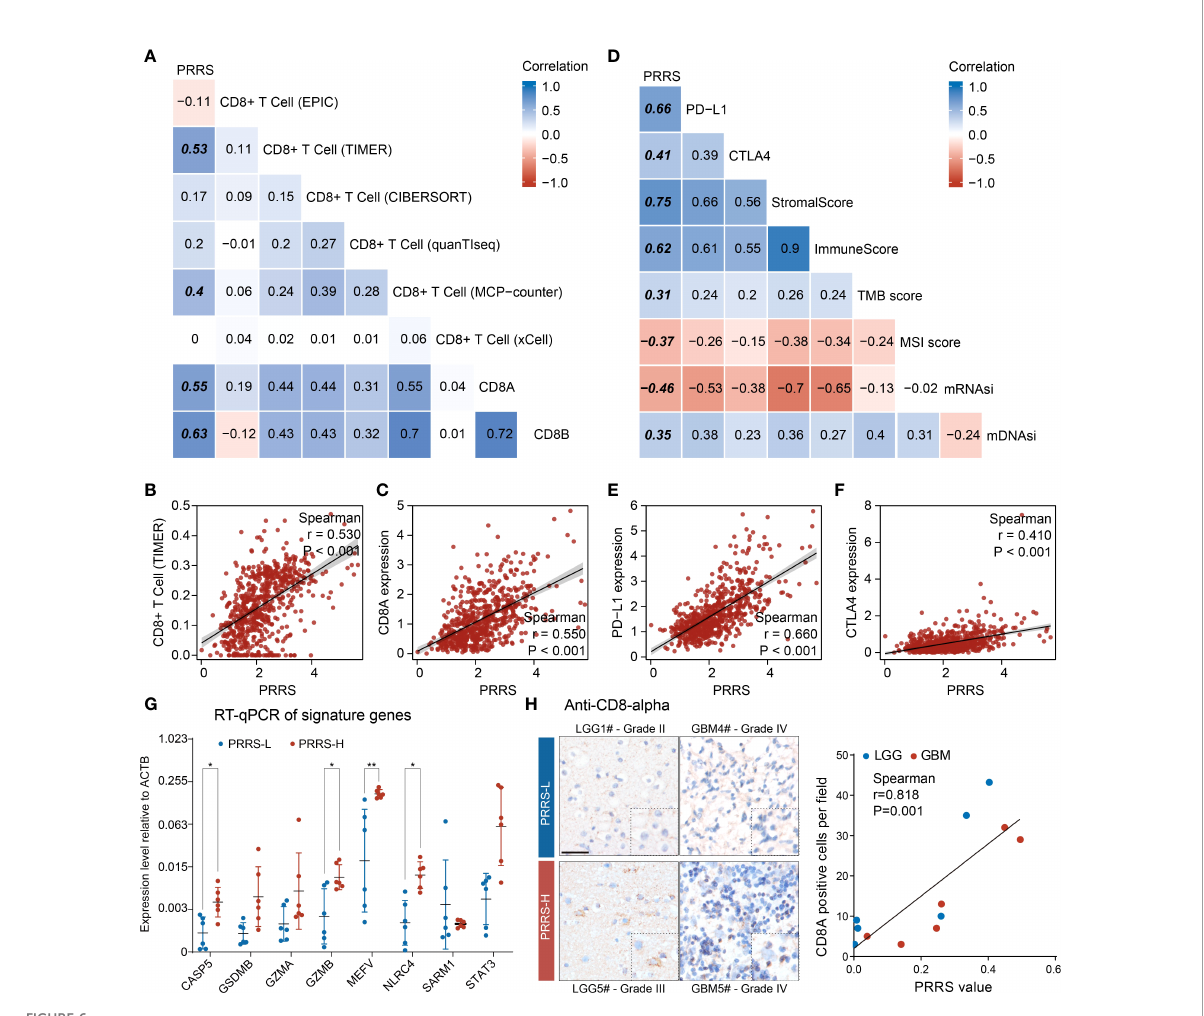
FIGURE 6 PRRS is correlated with CD8+ T cell in fi ltration in glioma. (A, B) The correlation between PRRS and CD8+ T cell was analyzed using EPIC, TIMER, CIBERSORT, quanTIseq, MCP-counter, and xCell algorithms. (C) Dot graph showed the correlation between PRRS and CD8A expression. (D) The correlation between PRRS and PD-L1, CTLA-4, Stromal score, Immune score, TMB score, MSI score, mRNAsi, and mDNAsi was analyzed. (E, F) Dot graph showed the correlation between PRRS and PD-L1 or CTLA-4 expression. (G) RT-qPCR analysis of signature genes in twelve glioma tissues. (H) The in fi ltration of CD8+ T cell was examined with anti-CD8- a staining in low- and high-PRRS glioma tissues, respectively, and correlation plot and Spearman ’ s correlation coef fi cient analysis were performed. Scale bar = 50 µm. *P < 0.05; **P <